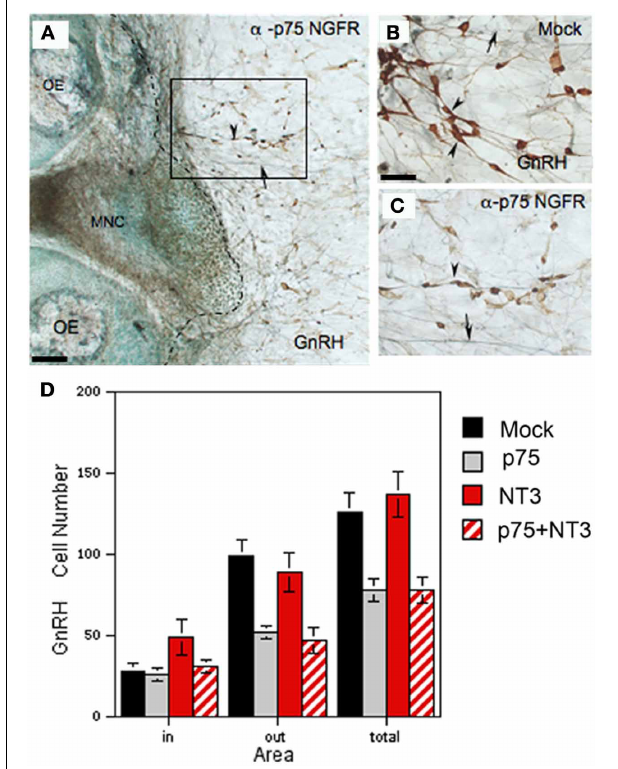
FIGURE 8 | Neutralization of endogenous p75NGFR decreases GnRH cell number. (A–C) Nasal explants immunocytochemically stained for GnRH (brown, arrowheads) and peripherin (blue, arrows) at 6div after blocking antibody treatment ( A,C ; α -p75 NGFR) and in control condition ( B , mock: rabbitIgG,1:6000).Inhibitionofp75NGFRappearedtodecreasethenumber of GnRH neurons in the periphery ( C , arrowheads) as compared to the mock (B) , arrowheads, the dashed line in (A) indicates the border of the explant tissuemass. (D) Histogramshowingthemeancellnumber ofGnRHneurons detected in the tissue (in), in the periphery of explant (out) and the total number (total) in 4 treatment groups: control (mock, black), anti-p75NGFR (gray bars), NT-3 (red bars) and anti-p75NGFR + NT-3 (red hatched bars). Anti-p75NGFR ± NT-3treatmentsignificantlydecreasedthenumberofGnRH cells in the periphery (out) and total number of GnRH neurons (total) in comparison with the control and NT-3 treated groups ( p < 0 . 001).